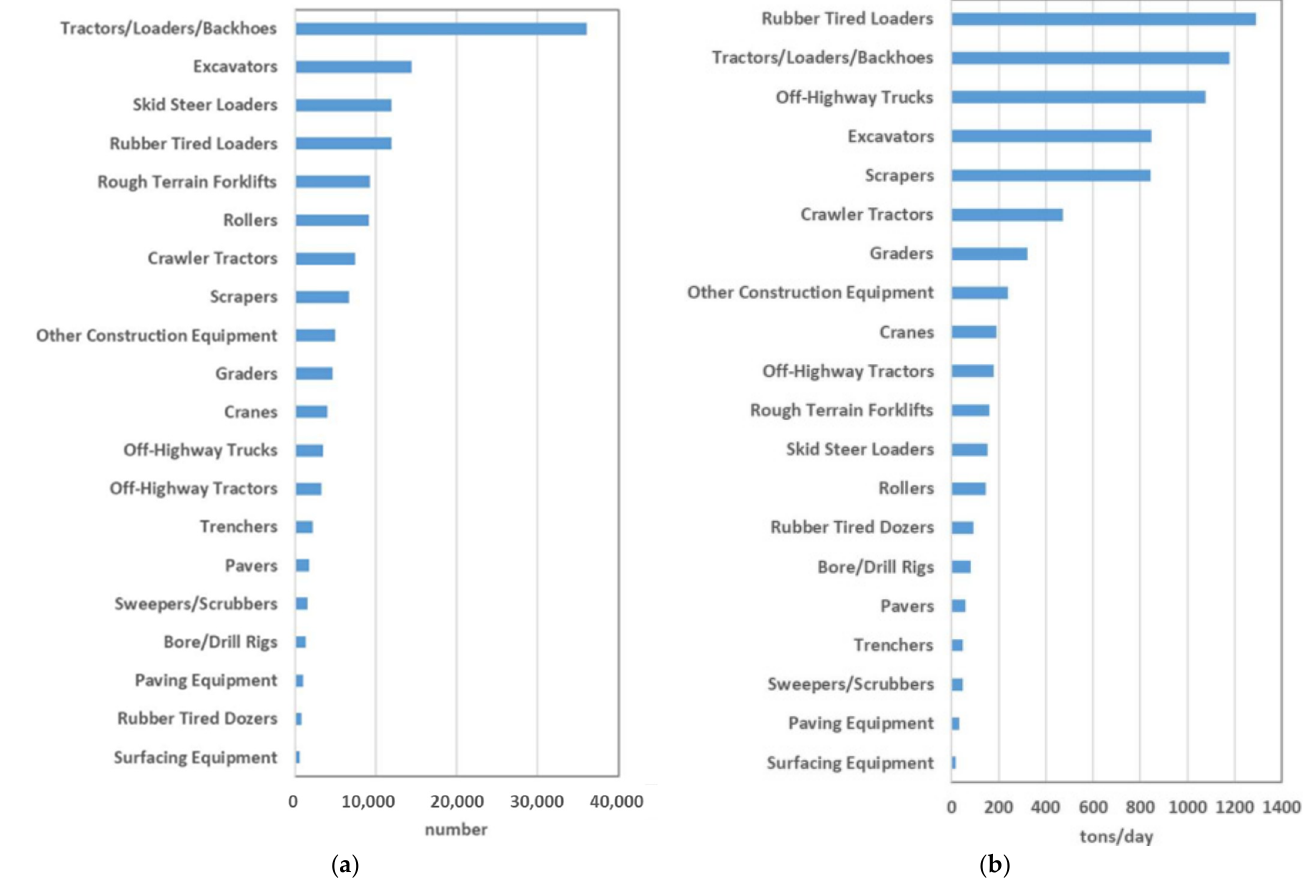
Figure 1. ( a ) Population and ( b ) CO 2 emission of various construction equipment types in California in 2018 (adapted from [24]).